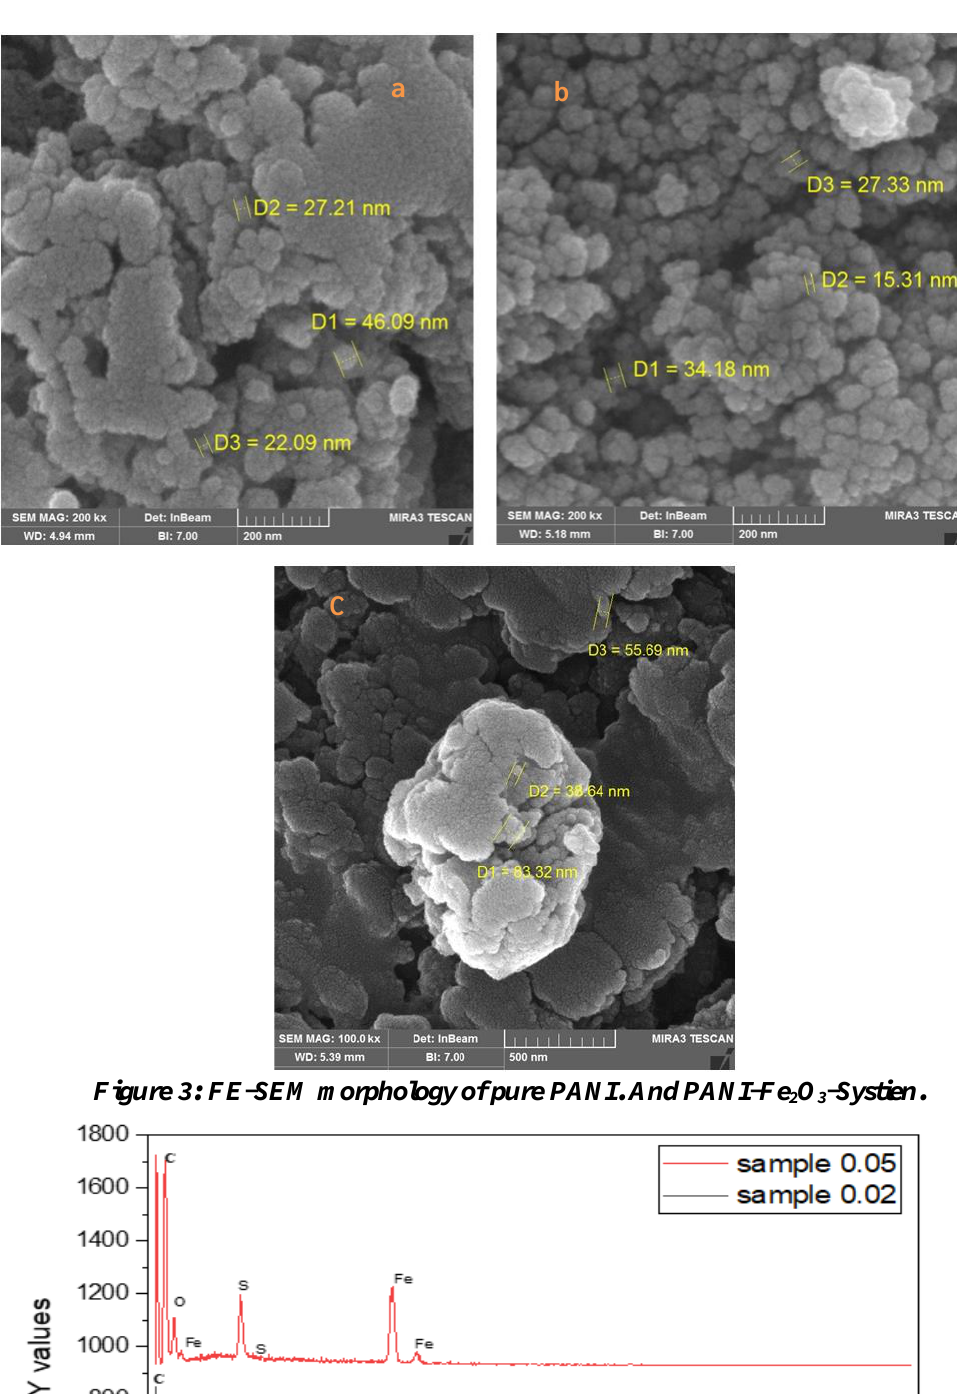
Figure 3: FE-SEM morphology of pure PANI. And PANI-Fe